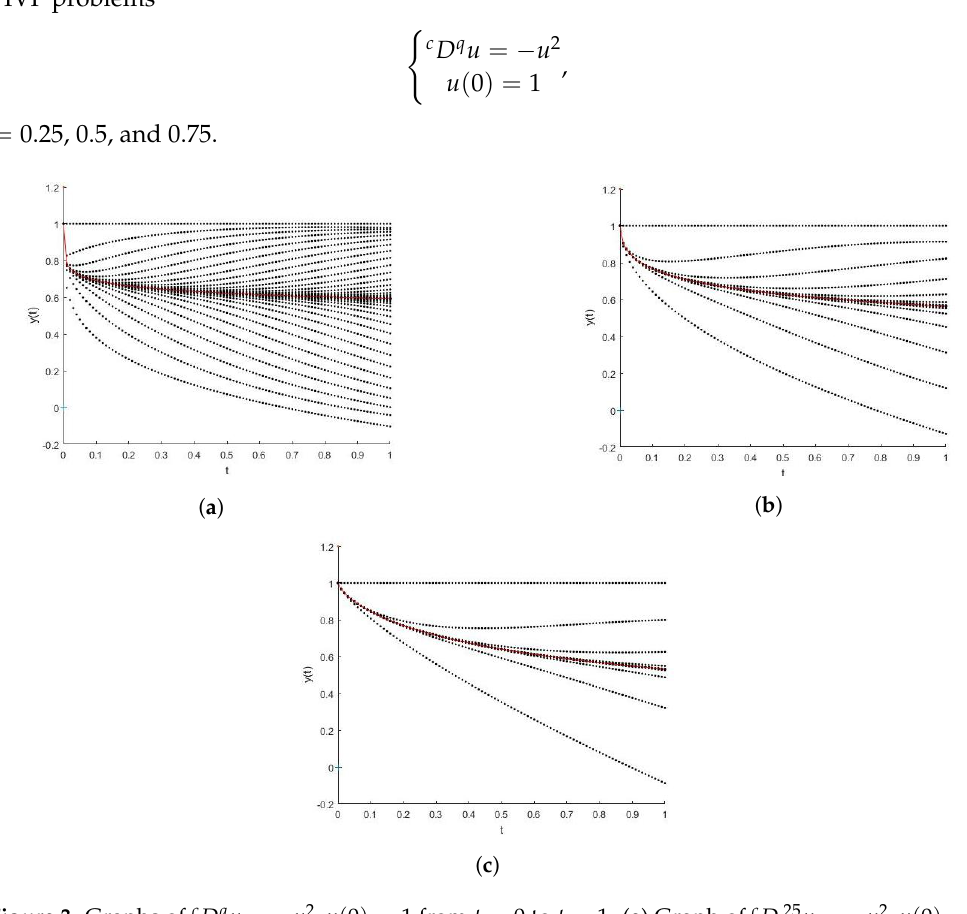
Figure 3. Graphs of c D q u = − u 2 , u ( 0 ) = 1 from t = 0 to t = 1. ( a ) Graph of c D .25 u = − u 2 , u ( 0 ) = 1. ( b ) Graph of c D .5 u = − u 2 , u ( 0 ) = 1. ( c ) Graph of c D .75 u = − u 2 , u ( 0 ) =